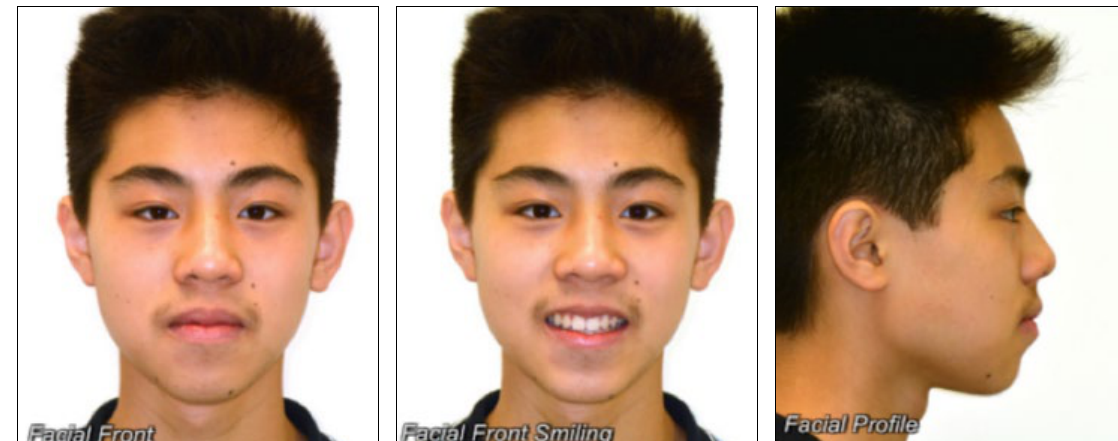
Figure 9. End of treatment extra-oral photographs.